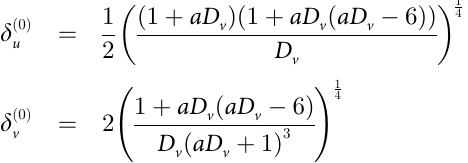
PLOS ONE | https://doi.org/10.1371/journal.pone.0220994 August 9,